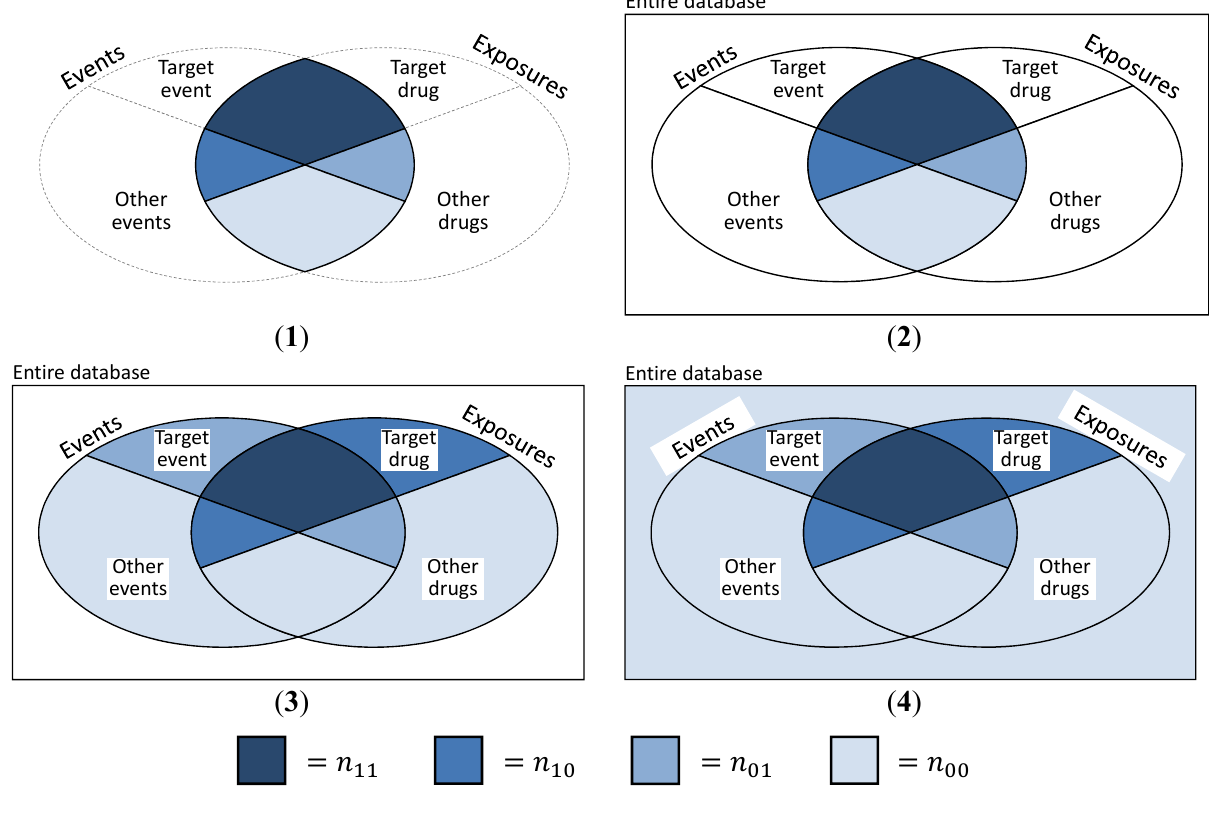
Figure 4. Diagrams to illustrate the different levels of information included when mapping longitudinal data (LD) to 2 × 2 cross-classification tables. ( 1 ) Structure of genuine spontaneous reporting (SR) data, only events under drug exposure are available; ( 2 ) “Pseudo”-SR, generated from LD. Only events under exposure are considered, similar to genuine SR data. None of the additional exposure information in LD is used; ( 3 ) Modified “pseudo”-SR, also including information on events without exposure and exposure periods without event. Some of the additional information contained in LD is used; ( 4 ) Considering all information available, including exposure- and event-free